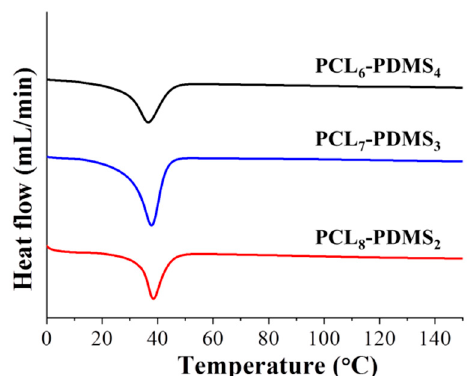
Figure 4. The di ff erential scanning calorimetry (DSC) curves of the electro-spun PCL–PDMS copolymer Figure 4. The differential scanning calorimetry (DSC) curves of the electro-spun PCL–PDMS nanofibres by the second heating run. copolymer nanofibres by the second heating run.